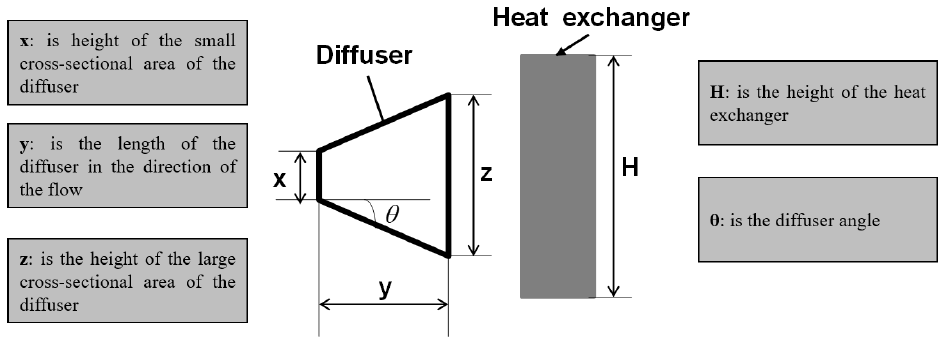
Figure 11. Elements of the parametric analysis.